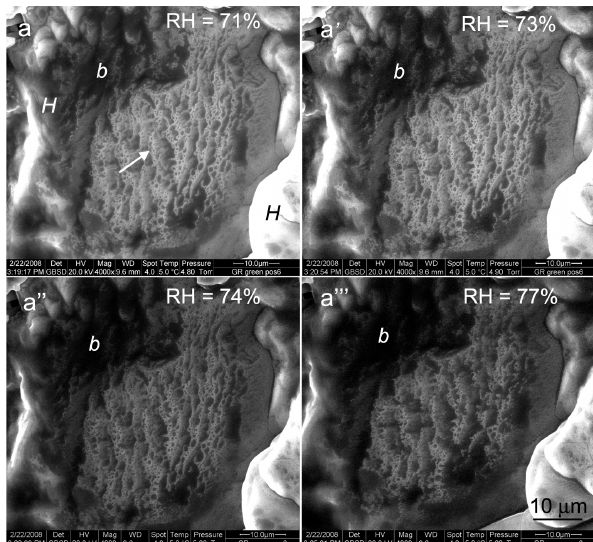
Fig. 9. Sequence of ESEM images ( a–a”’ ) of a halite sample show- ing the foam-like phase (arrow in a ) among larger halite crystals ( H) in sample hydrated inside the ESEM chamber from RH of 71% to 77%; ( b) , brine